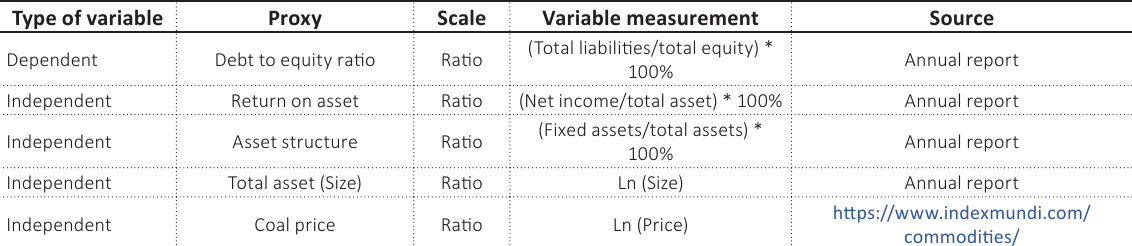
Table 1. Operational variable